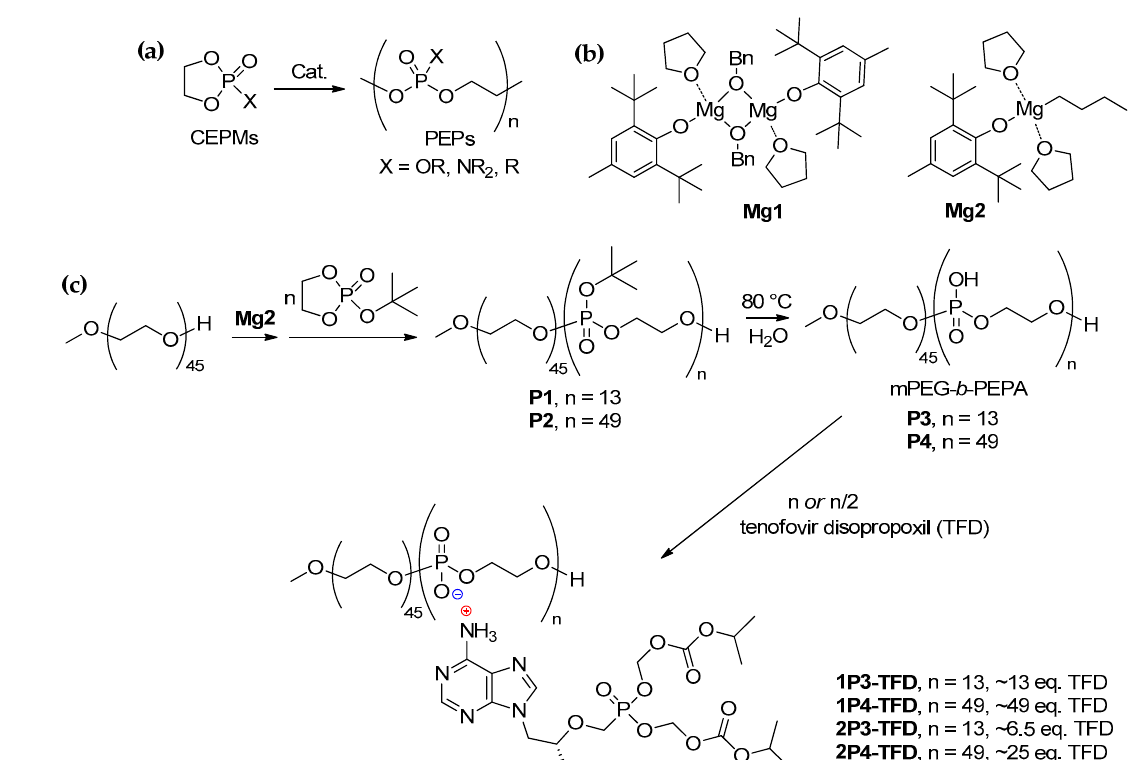
Scheme 1. ( a ) Ring-opening polymerization (ROP) of cyclic ethylene phosphate monomers (CEPMs); ( b ) 2,6-di- tert -butyl-4-methylphenoxy (BHT)-Mg complexes, efficient catalysts of living ROP of CEPMs; ( c ) Controlled synthesis of poly(ethylene phosphoric acid) (PEPA) block copolymers and adducts with tenofovir disoproxil (TFD) [29].